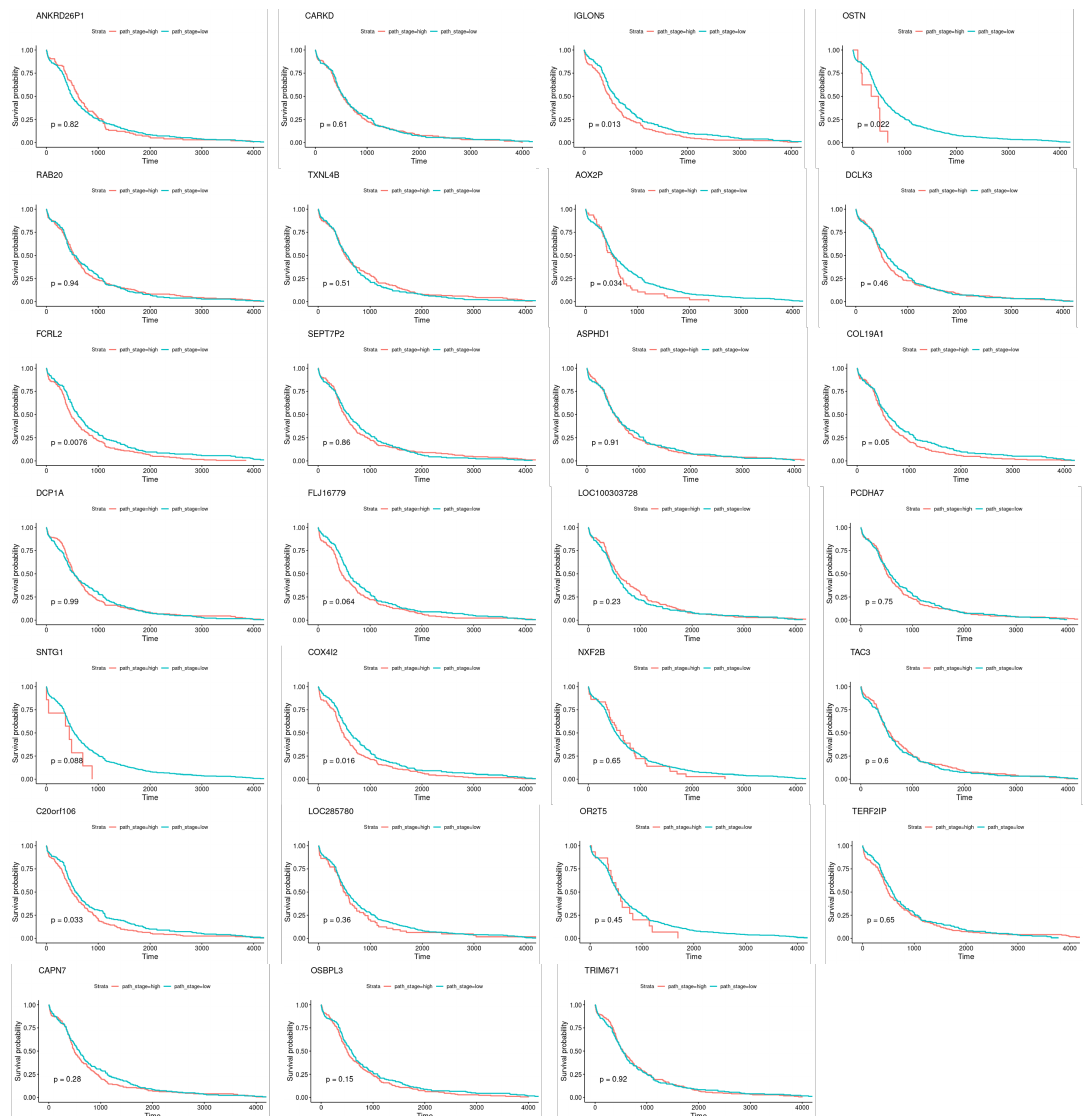
Figure 9. Survival curves obtained for the genes exclusively selected by the TCox method, when analyzed